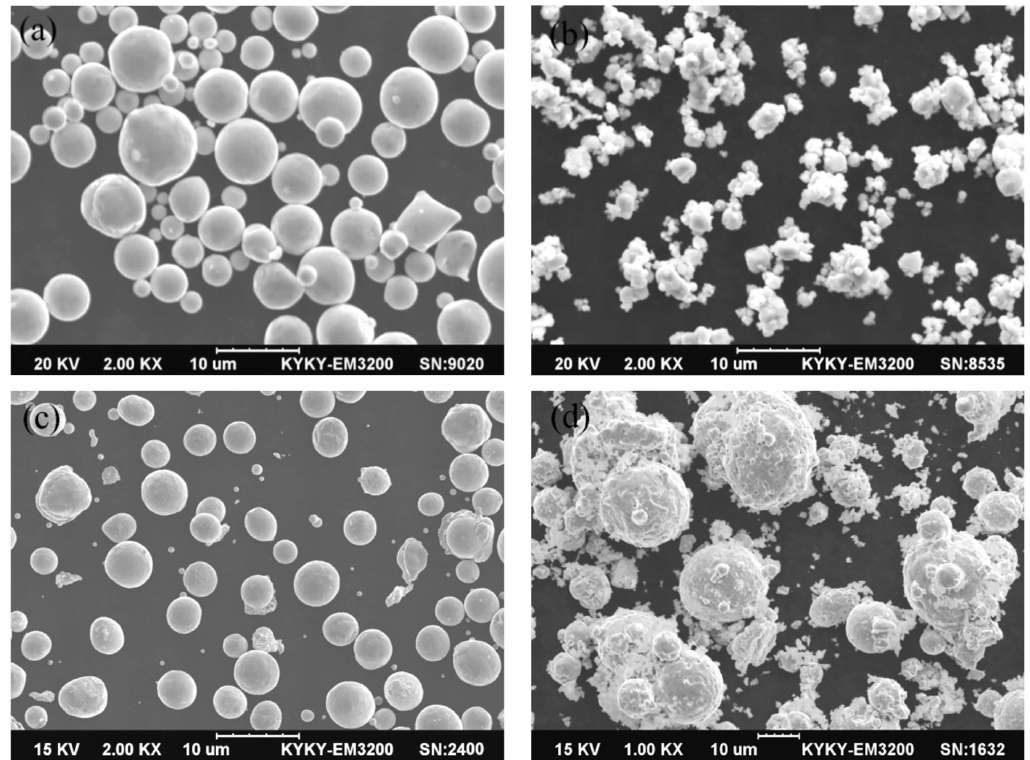
Figure 1. SEM micrographs of powders ( a ) Cu-Gd alloy; ( b ) Cu 2 O; ( c ) Cu; ( d ) Cu-Gd alloy and Cu 2 O after